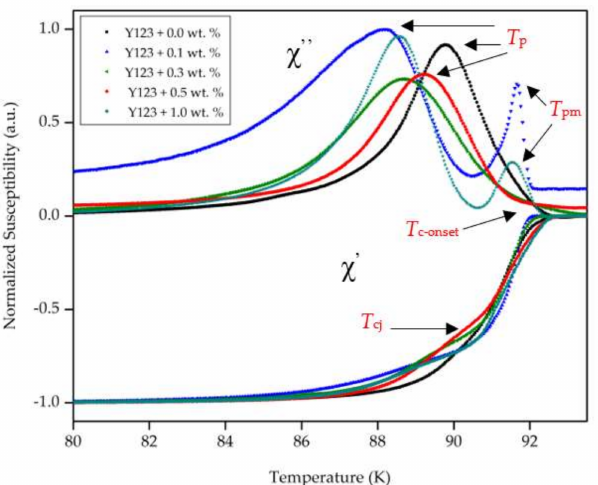
Figure 6. The real ( χ (cid:48) ) and imaginary part ( χ ”) of the AC susceptibility for Y123 under AC magnetic field of 0.5 Oe and frequency 219 Hz. The real part of samples shifted to the lower temperature up to 92.30 K for sample x = 0.1